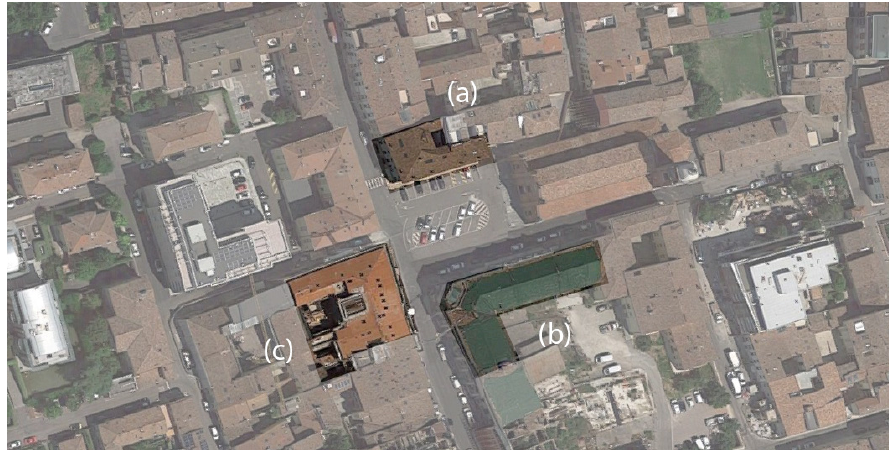
Figure 5. A view of the Mirandola case study site and the three buildings analysed. Three buildings facing the Conciliation Square were selected for the study, as seen in Figure 6. All three buildings have masonry load-bearing structures and are a part of larger aggregates.